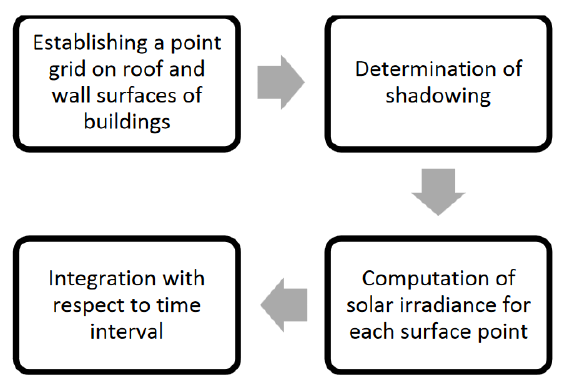
Figure 4. Basic workflow for the combined method (Wieland